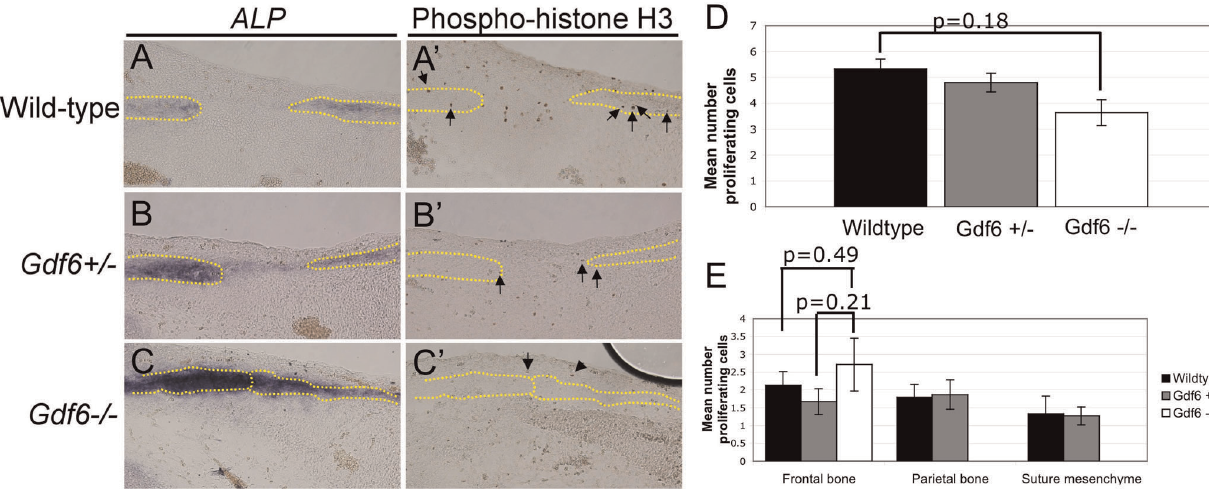
Figure 4. Analysis of cell proliferation in the E12.5 coronal suture. Adjacent sections stained for ALP activity, highlighting the location of the frontal and parietal bones (A–C dotted lines), and immunohistochemistry for phospho-histone H3 (A’–C’). Examples of positive cells are marked with arrows. (D) Quantification of the mean number of proliferating cells counted in the combined frontal/suture/parietal region. (E) Quantification of the mean number of proliferating cells counted in each region separately (the frontal bone, parietal bone, and suture mesenchyme) (x-axis). Since the suture mesenchyme cannot be distinguished from the parietal in Gdf6 2 / 2 embryos at this time, only data for the frontal rudiment is shown for this genoytpe. N=3 embryos for each genotype with 5 sections per embryo quantified. Differences the number of proliferating cells per suture region were analyzed using a t-test.